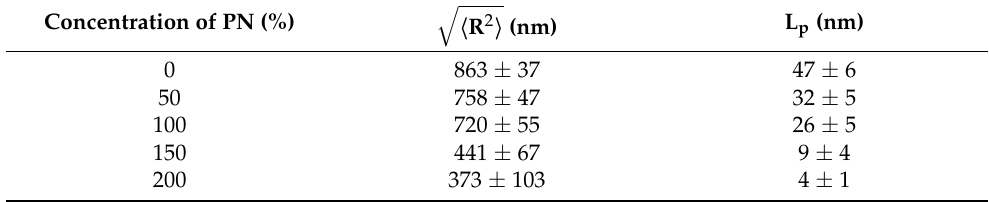
Table 1. Root-mean-square end-to-end distance of 4000 bp linear DNA at different concentrations of PN. Concentration of PN